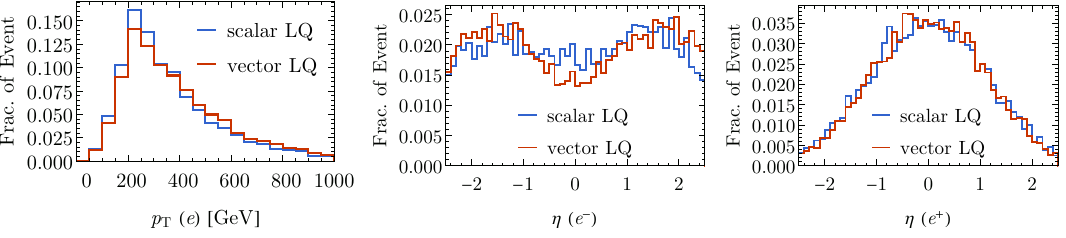
Figure 6. p T and (cid:17) distributions for electrons and positrons in the Drell-Yan process pp with t -channel exchange of (cid:30) eu . Here we set m (cid:30)